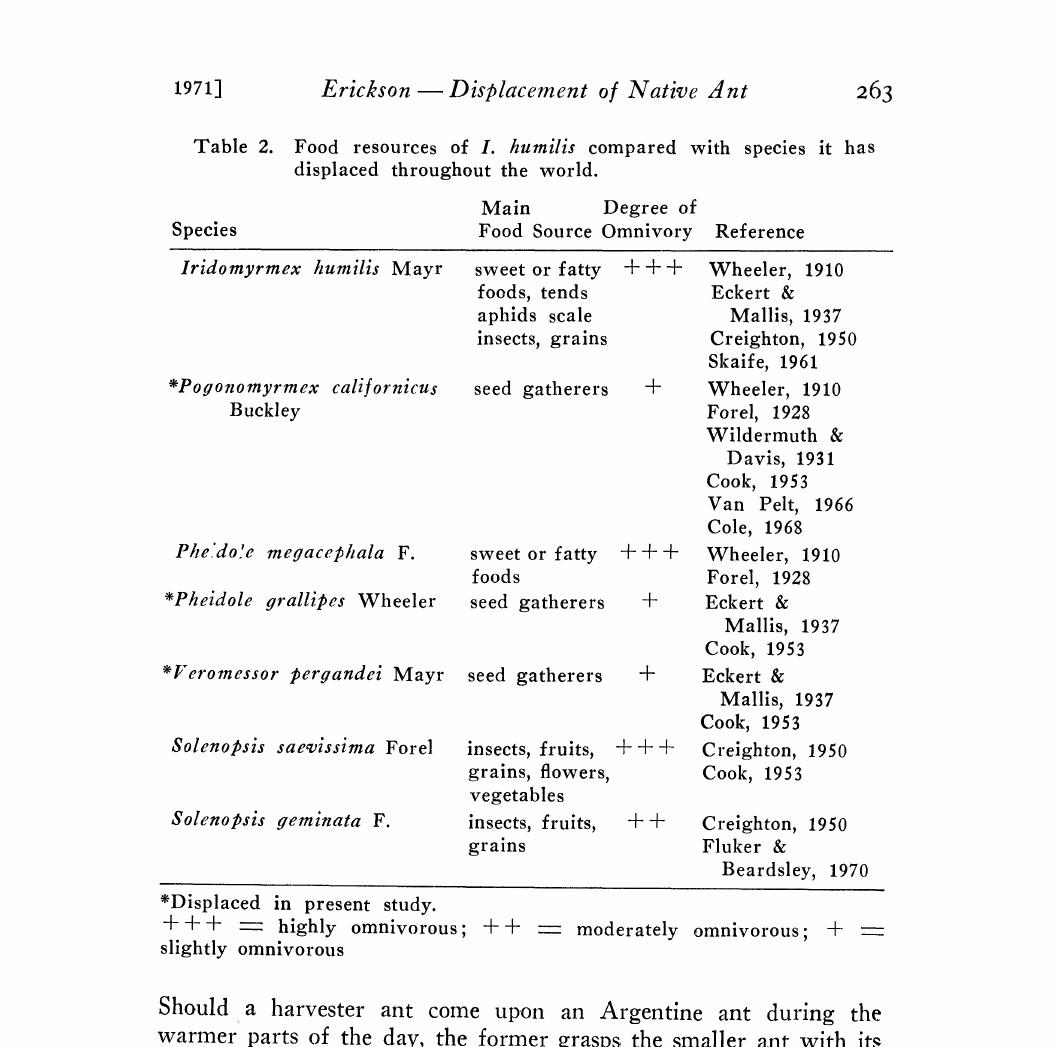
Food resources of I. humilis compared with species it has displaced throughout the world. Main Degree of Species Food Source Omnivory